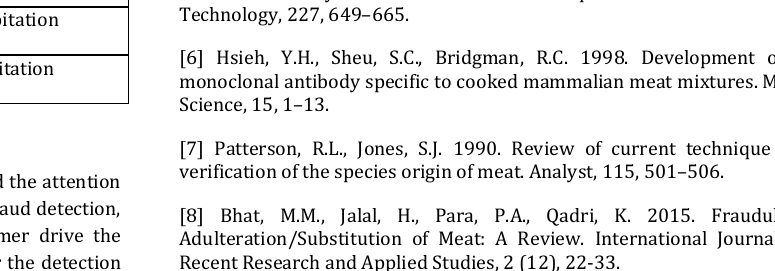
Table 4: Heterologous reactions Meat protein